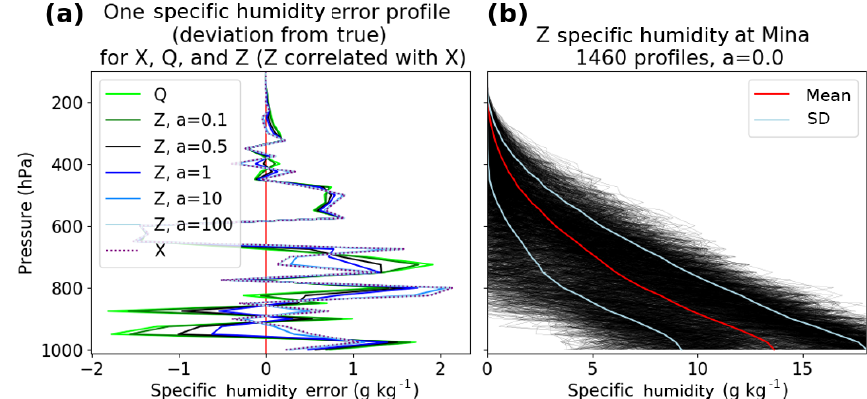
Figure 1. (a) One set of error profiles with the unnormalized X err (dotted line), Q err (solid lime green line) and Z err (various solid lines for different values of correlation parameter a ). Q err is uncorrelated with X err . For a = 0, Z err = Q err and Z err and X err are uncorrelated. As a increases, Z err is increasingly correlated with X err and looks less like Q err and more like X err . For very large a ( a = 100), Z err (light blue solid line) is almost equal to X err (dotted line). (b) 1460 profiles of the unnormalized data set Z with zero correlation with X ( a = 0). Table 1. Relationship between normalized error variances and standard deviations of data sets X and Z for different values of a . a r σ Z /σ X VAR err (Z) (% 2 ) COV err (X,Z) (% 2 ) err err 0.0 0.0 1.0 1.00 VAR err (X) 0.0 0.1 0.0995 0.9136 0.84 VAR err (X) 0.0909 VAR err (X) 0.3 0.287 0.803 0.65 VAR err (X) 0.230 VAR err (X) 0.5 0.447 0.745 0.55 VAR err (X) 0.333 VAR err (X) 1.0 0.707 0.707 0.50 VAR err (X) 0.500 VAR err (X) 2.0 0.894 0.745 0.55 VAR err (X) 0.666 VAR err (X) 10.0 0.995 0.913 0.83 VAR err (X) 0.908 VAR err (X) 100.0 0.99995 0.9901 0.98 VAR err (X) 0.990 VAR err (X) ∞ 1.0 1.0 1.00 VAR err (X) 1.0 VAR err